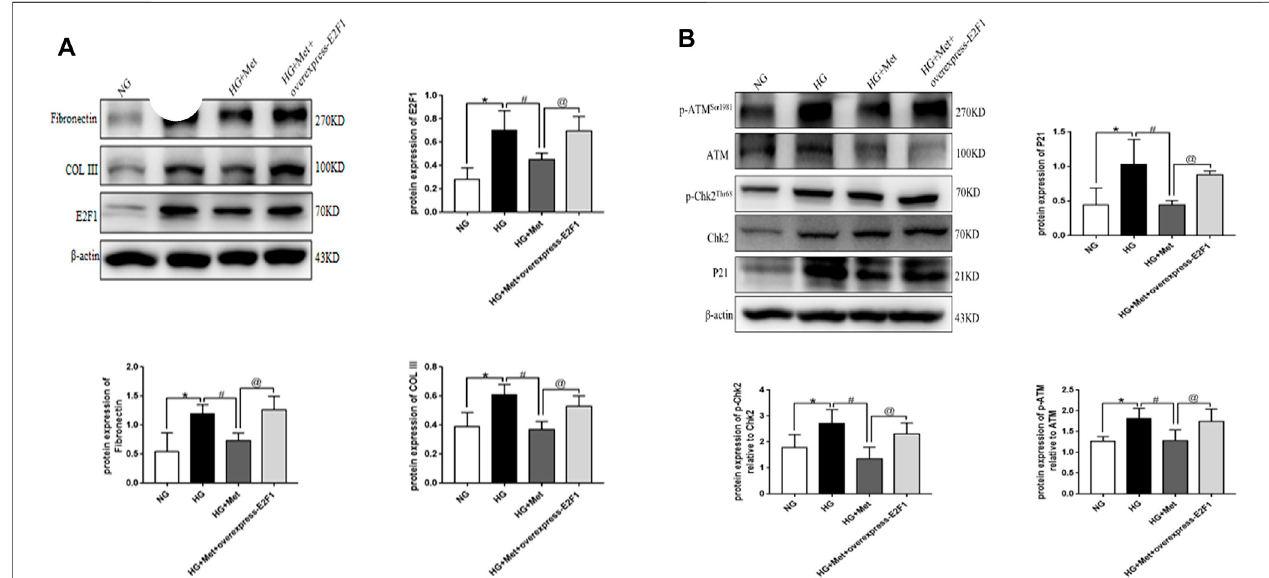
FIGURE 8 | Metformin improves renal injury in the high-glucose state through E2F1. (A) Western blot analysis of E2F1, Fibronectin, and COL III in mRTECs (n = 3, * p < 0.05vs.NG, # p < 0.05vs.HG, @ p < 0.05vs.HG+Met). (B) WesternblotanalysisofATM,p-ATM Ser1981 ,Chk2,andp-Chk2 Thr68 inmRTECs(n=3,* p < 0.05vs.NG, # p < 0.05 vs. HG, @ p < 0.05 vs. HG +